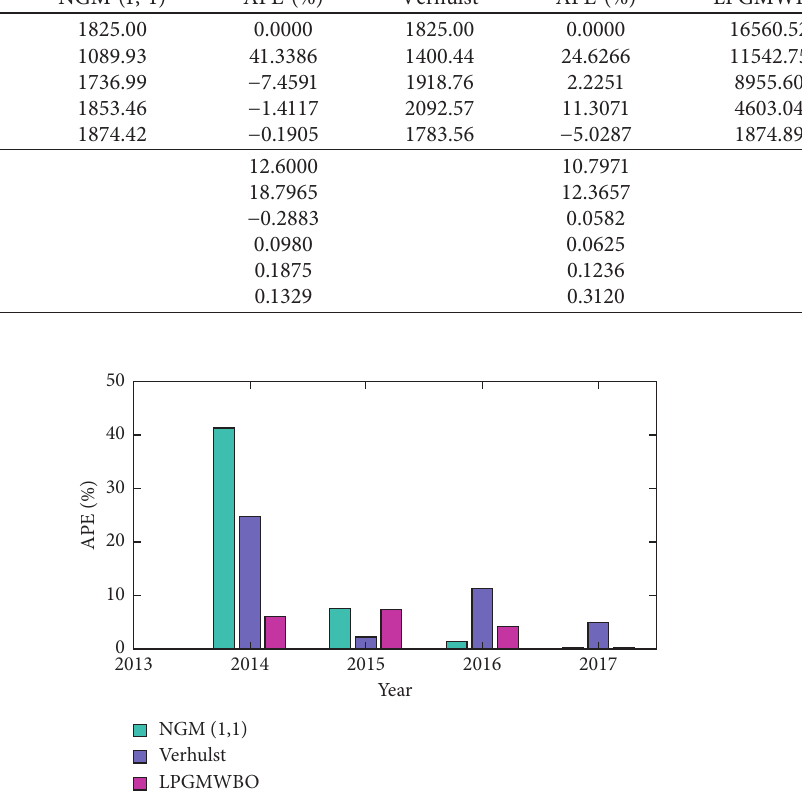
Figure 2: APE values of the three model validations of Beijing data. Table 7: Fitting metrics of models for validation of Shanghai